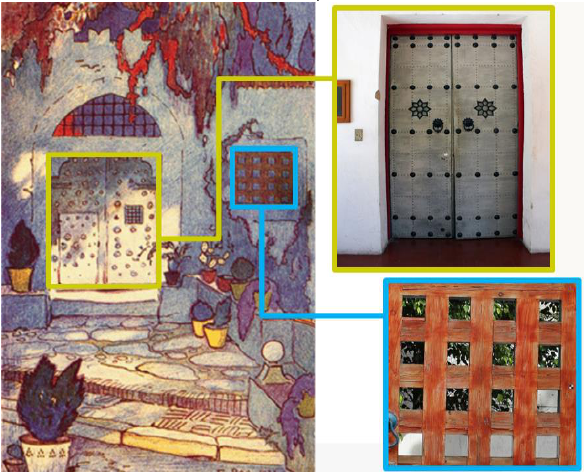
Fig.2 Influences of Ferdinand Bac’s illustrations on Luis Barragán architecture of Casa Cristo. Image source: authors